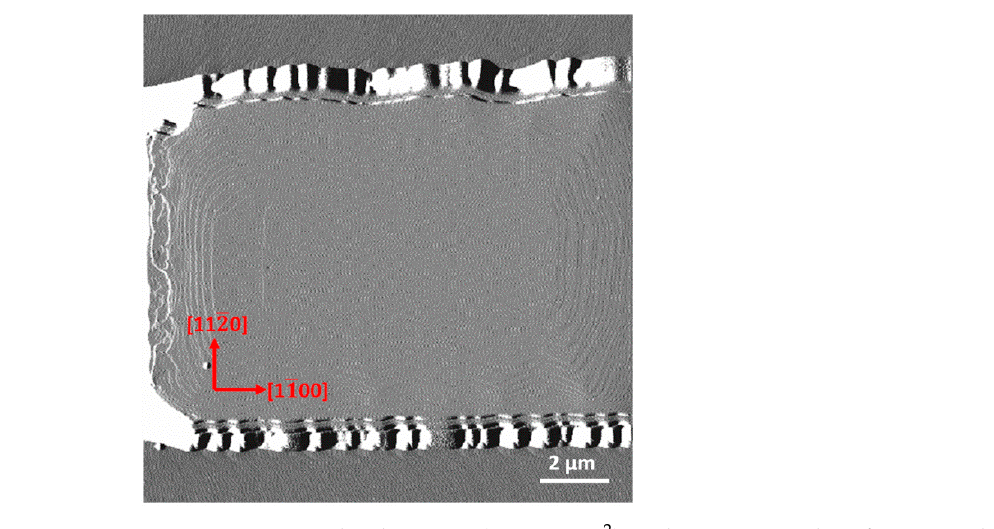
Figure 5. AFM amplitude images (14 × 14 μ m 2 ) on the upstream edge of 10 μ m-wide stripe along the m-direction for sample A.